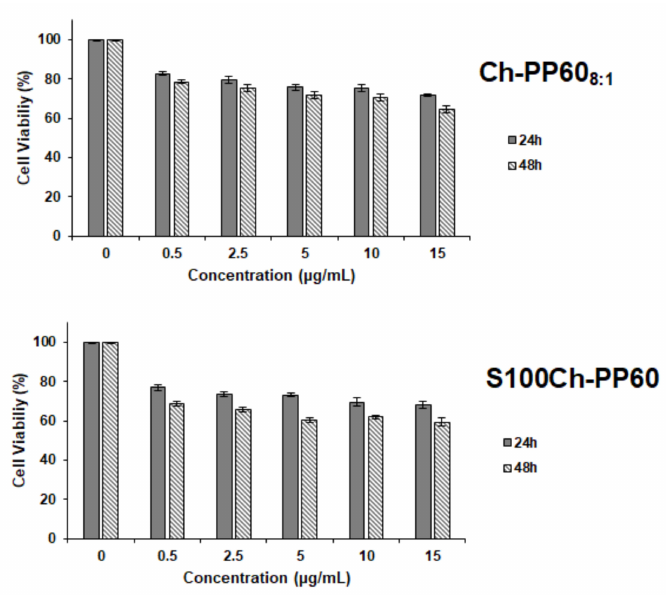
Figure 4. Evaluation of the cytotoxic activity of Ch-PP60 8:1 and S100Ch-PP60 in Caco-2 cell line using the MTT assay at 24 and 48 h. The data represent the mean values ± SD ( n =